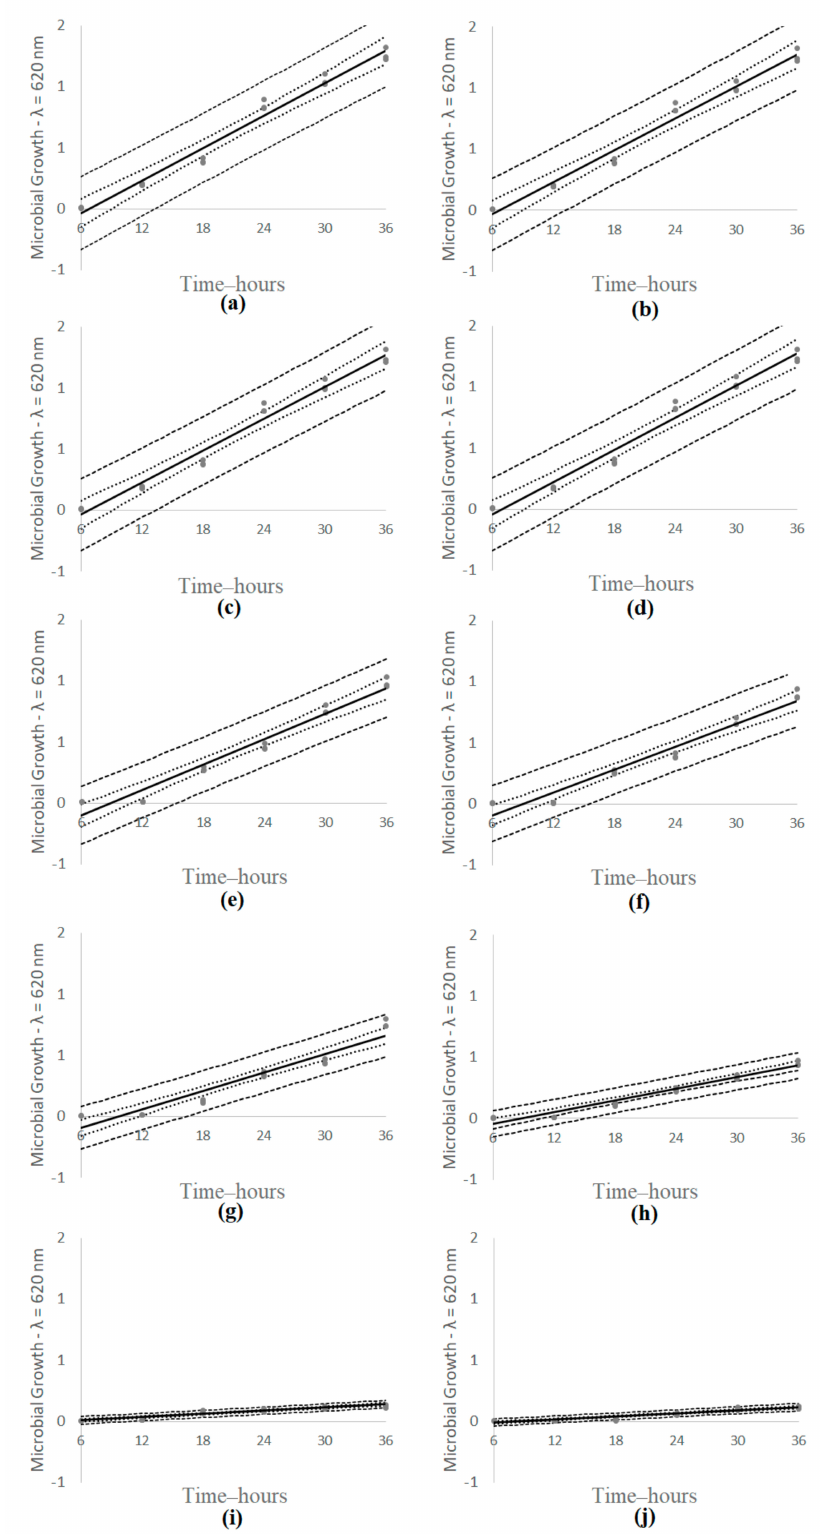
Figure 3. Linear regression (—-), confidence interval for the mean ( . . . .), and prediction interval for the sample (—) of the period with microbial growth (from 6 to 36 h of incubation at 36 ◦ C) at different concentrations of potentially postbiotic-containing preservative (PPCP): ( a ) 0.0%; ( b ) 0.1%; ( c ) 0.3%; ( d ) 0.5%; ( e ) 1.0%; ( f ) 1.5%; ( g ) 2.0%; ( h ) 2.5%; ( i ) 3.0%; ( j )